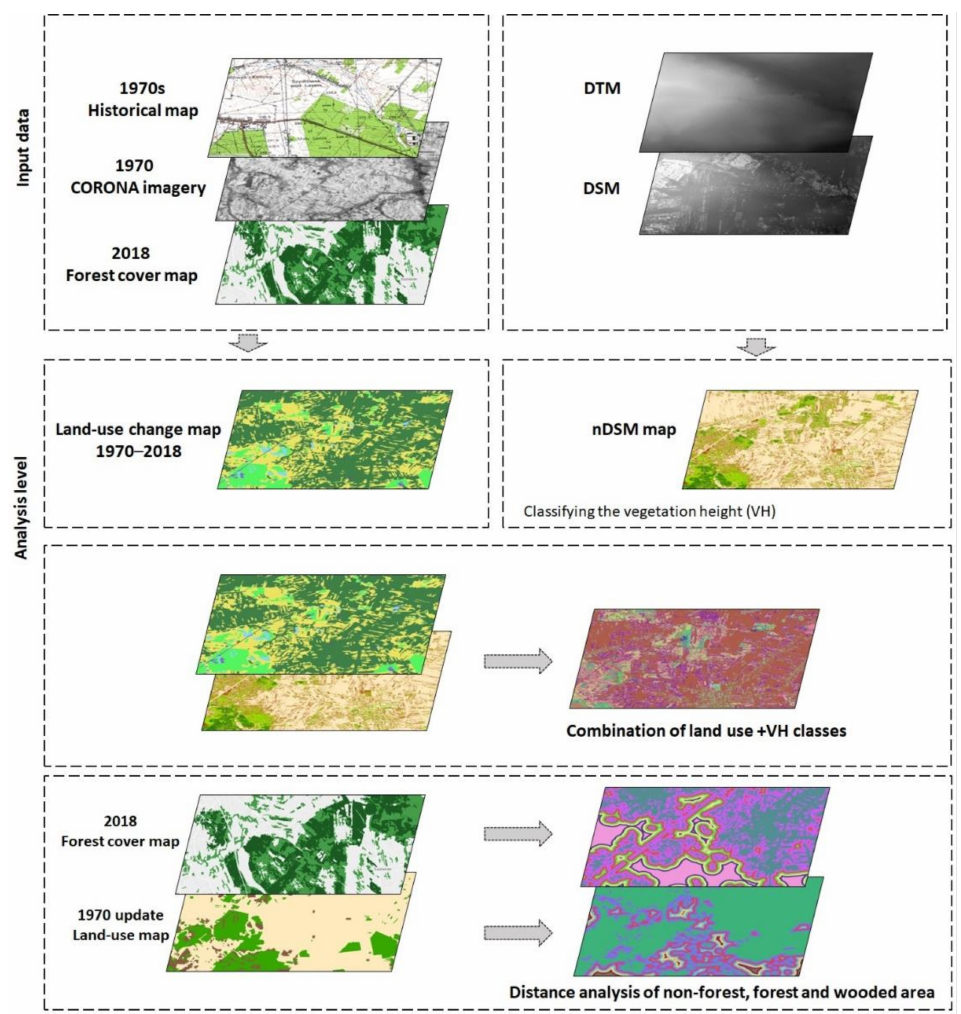
Figure 2. Flowchart of data preparation and